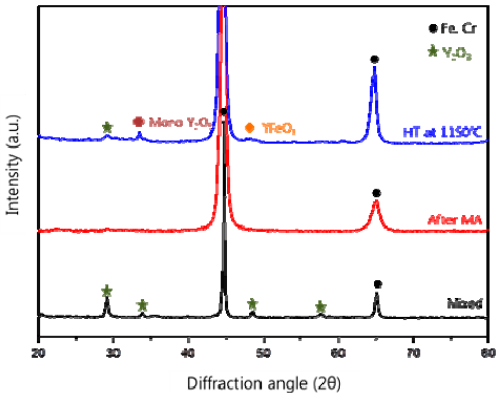
Figure 6. X-ray diffraction patterns of the Fe-10Cr-5Y 2 O 3 powders before MA, after MA and after a heat treatment at 1150°C for 1 h.